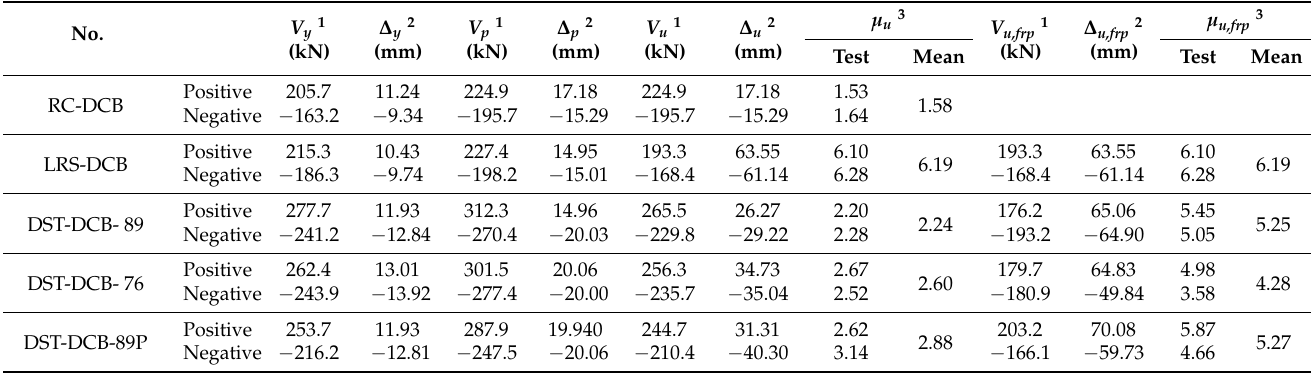
Table 4. Test results of all